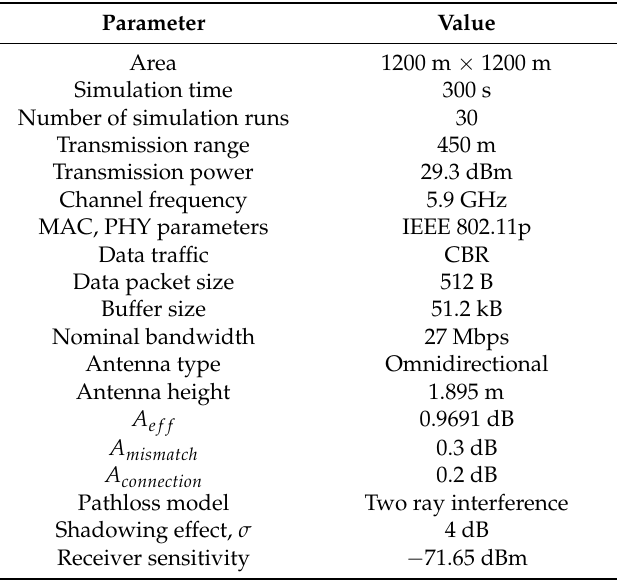
Table 2. Simulation